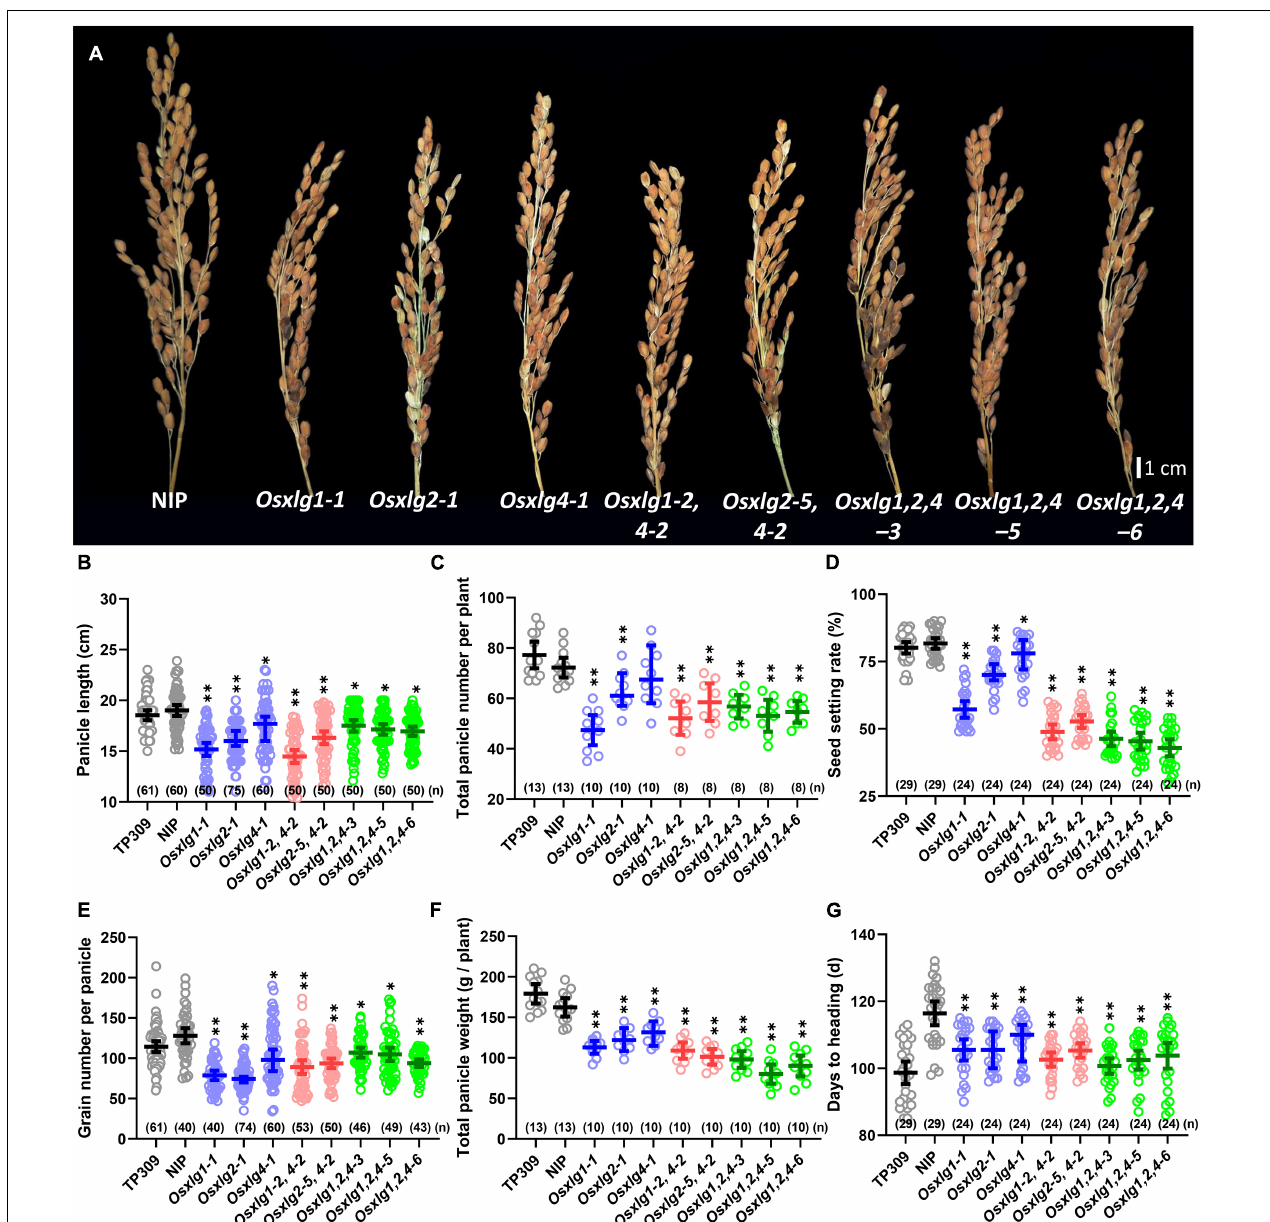
FIGURE 4 | Panicle phenotype of rice Osxlg plants. Genetic effect of Osxlg mutations on panicle size and grain yield. Panicle images (A) , panicles length (B) , total number of panicle per plant (C) , seed setting rates (D) , grain number per panicle (E) , total panicle weight per plant (F) , and days to heading (G) from controls and Osxlg single, double, and triple mutants. Significant differences between WT-NIP and Osxlg mutants were determined with one-way ANOVA with the p -values that are expressed as ∗ p < 0.05, ∗∗ p < 0.001. ( n ) = sample size, Bar = 1 cm.